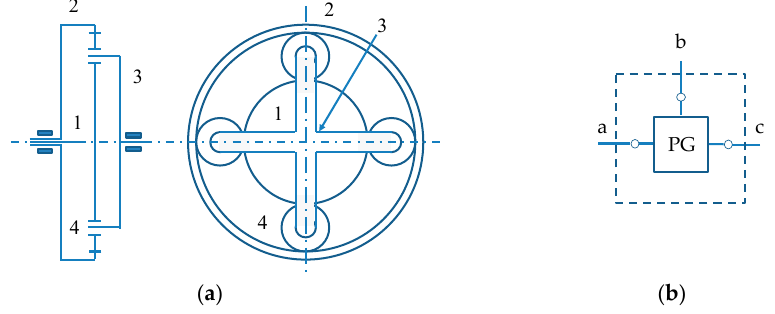
Figure 6. ( a ) Planetary gear scheme; ( b ) three-port diagram. (1—sun gear (S); 2—ring gear (R); 3—carrier (C); 4—planet gear (PG)).